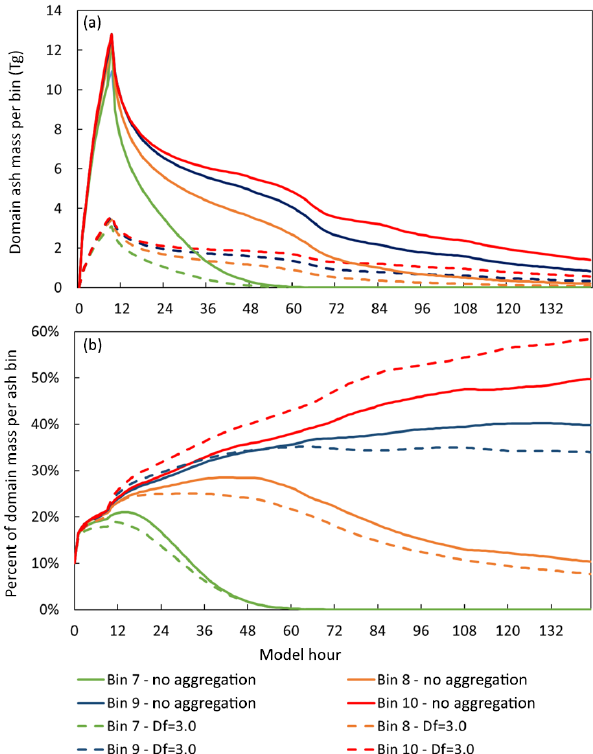
Figure 6. Total domain mass (a) and particle size distribution (b) of volcanic ash bins 7 to 10 when considering a hypothetical eruption on 5 May, beginning at 00:00Z and ending at 09:00Z, and a fractal dimension D f = 3 . 0. Constant eruption rate = 4 × 10 6 kgs − 1